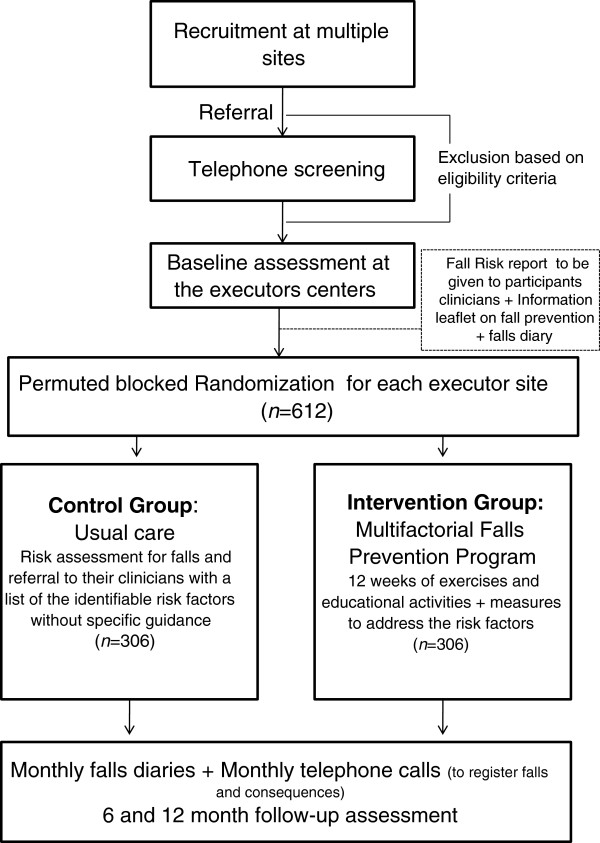
Design of study.